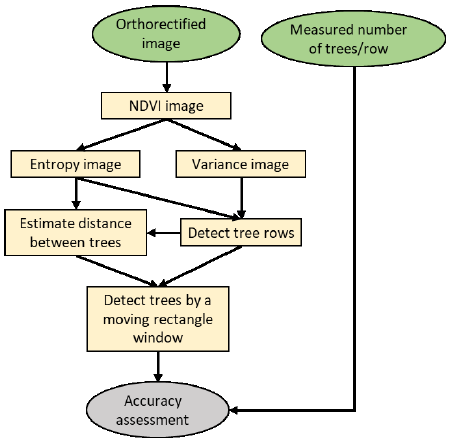
Figure 1. Flowchart of the proposed method. The UAV images were first orthorectified and mosaicked together using Pix4D ( Pix4D, Lausanne, Switzerland )